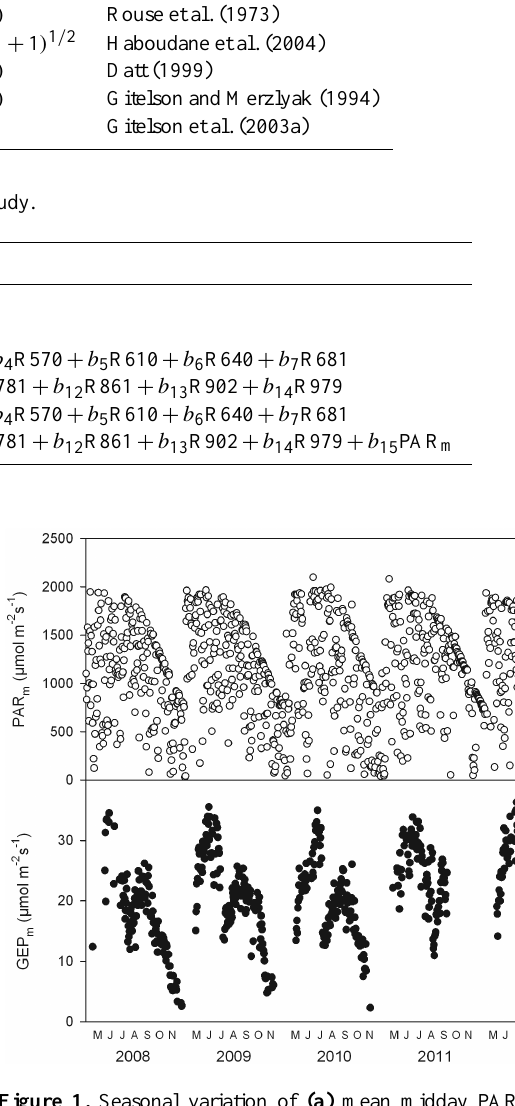
Figure 1. Seasonal variation of (a) mean midday PAR (PAR m ; µmolm − 2 s − 1 ) and (b) mean midday GEP (GEP m ; µmolm − 2 s − 1 ) in the growing seasons of